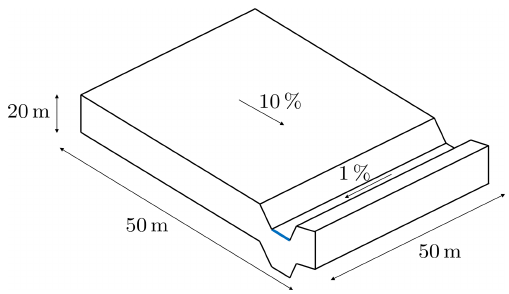
Figure 1. Dimensions and topography of the hillslope model. The blue line denotes the outlet.